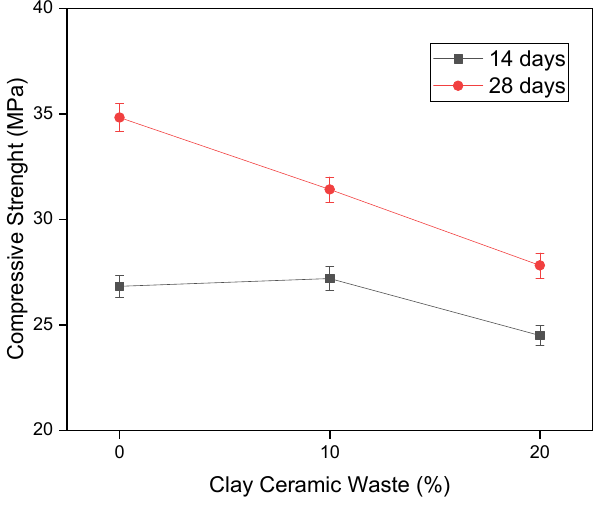
Figure 3. Compressive strength.